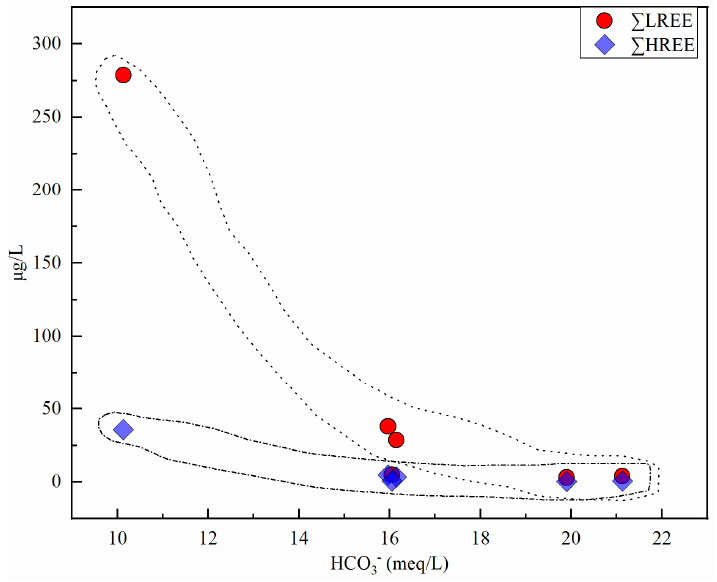
Figure 7. Relationship between ∑ LREE, ∑ HREE, and HCO 3 − in Boiling-Wells water.